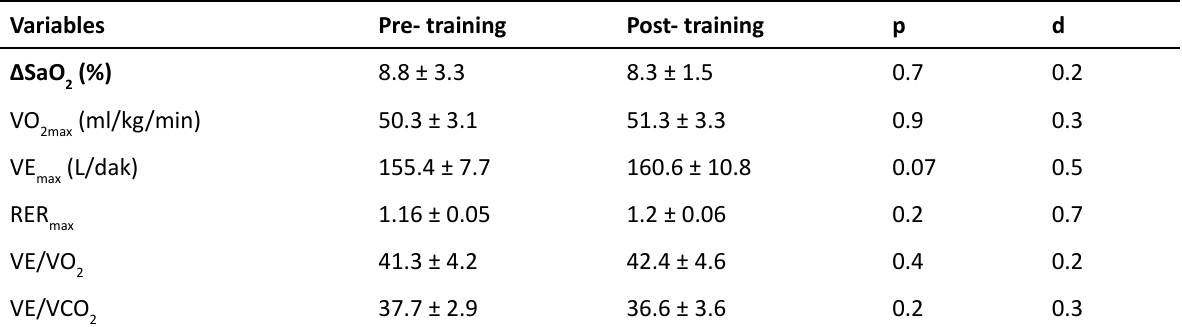
Table 1. Results of the incremental treadmill test of the volleyball players before (pre) and after (post) the 6-week training period